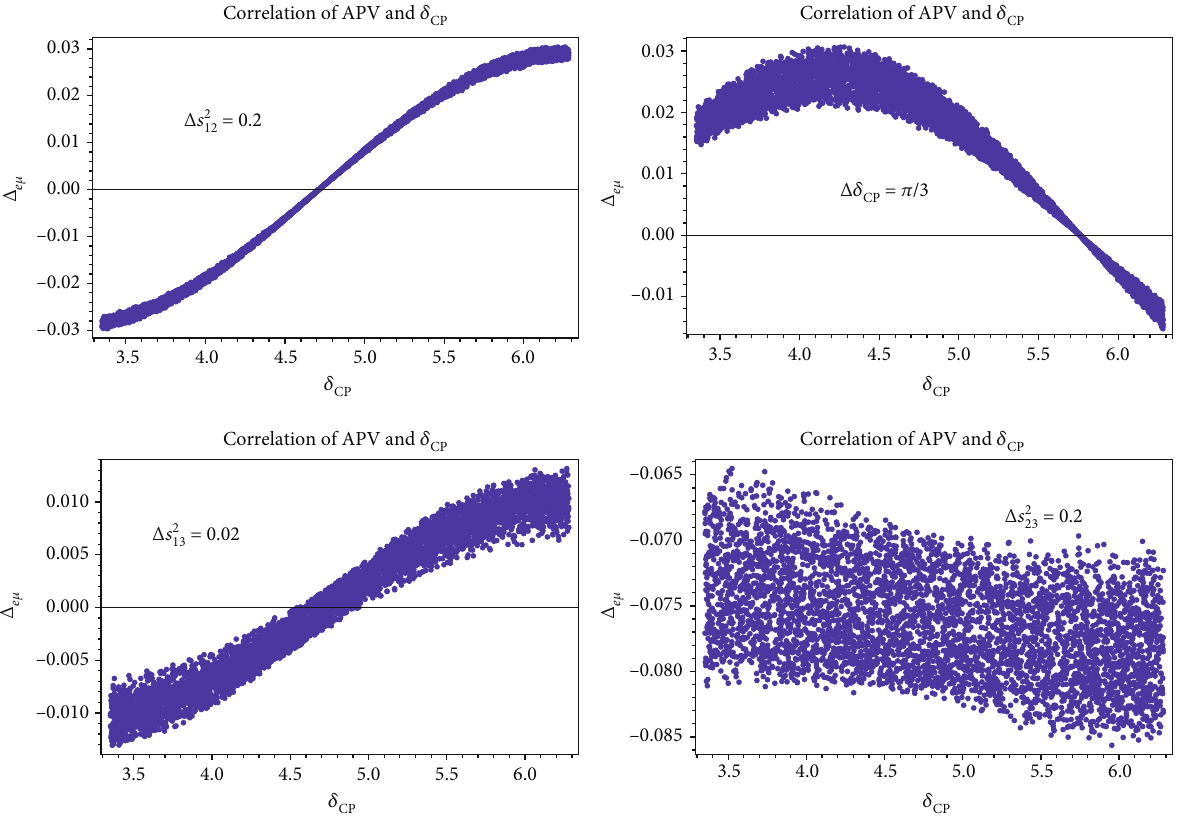
Figure 7: The correlation between the apparent P violation (APV) and the CP phase with the inverted mass ordering. The conventions of the modi fi ed mixing parameters are the same as those in Figure 6.